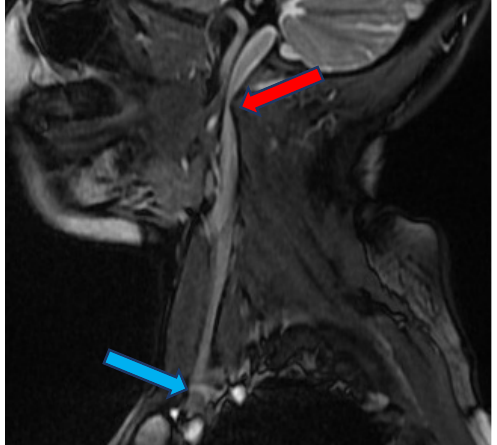
Figure 1. The internal jugular vein with stricture in its upper part (red arrow), blue arrow points to the location of the jugular valve.